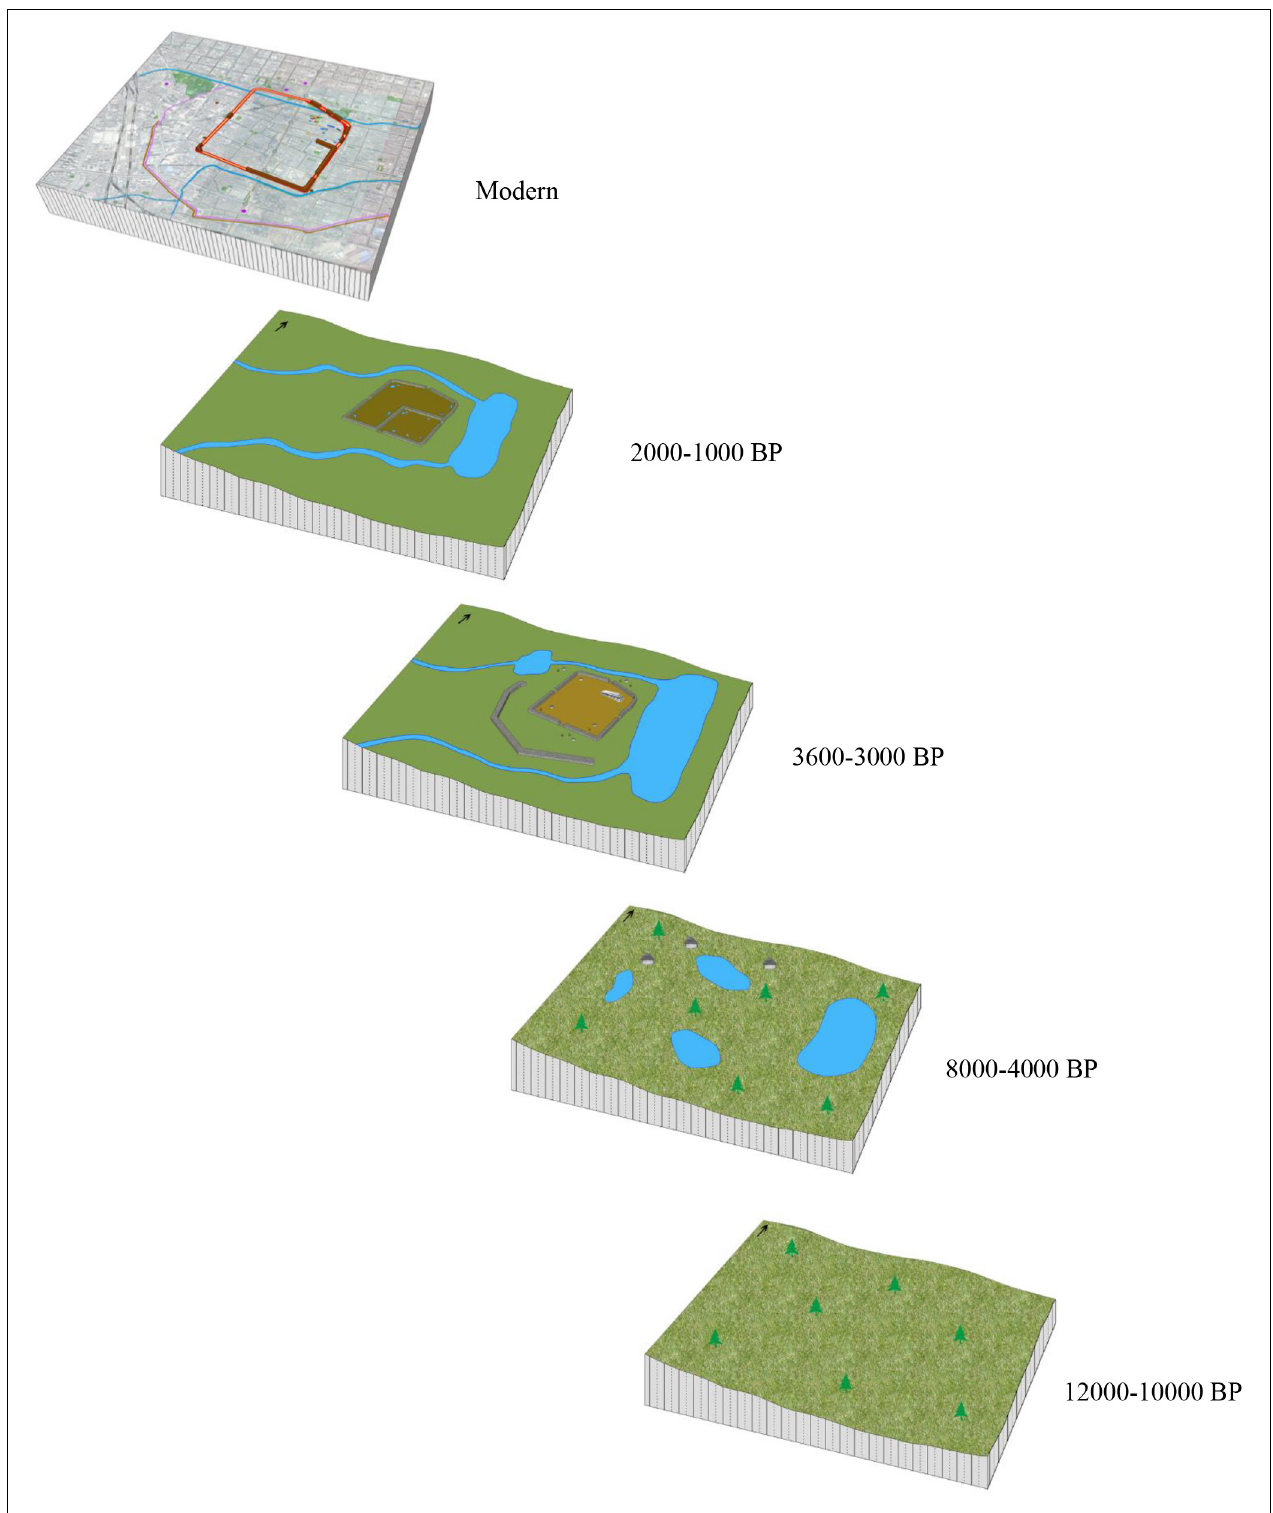
FIGURE 5 | The landscape evolution in the area of Zhengzhou Shang City (During 12,000-10,000 BP, the landform was changed to alluvial plain. During middle Holocene periods (8,000-4,000 BP), there were many natural water areas under a warm and humid climate and river aggradation (Chen et al., 2015; Tan et al., 2020; Lu et al., 2021). In 3,600 BP, the Shang city was built. During 2,000-1,000 BP, the city size was shrank and some watery areas disappeared, consistent with the declining intensity of the summer monsoon on the Loess Plateau (Tan et al., 2020).In the Modern, Zhengzhou city is located on the former site of the Shang City.